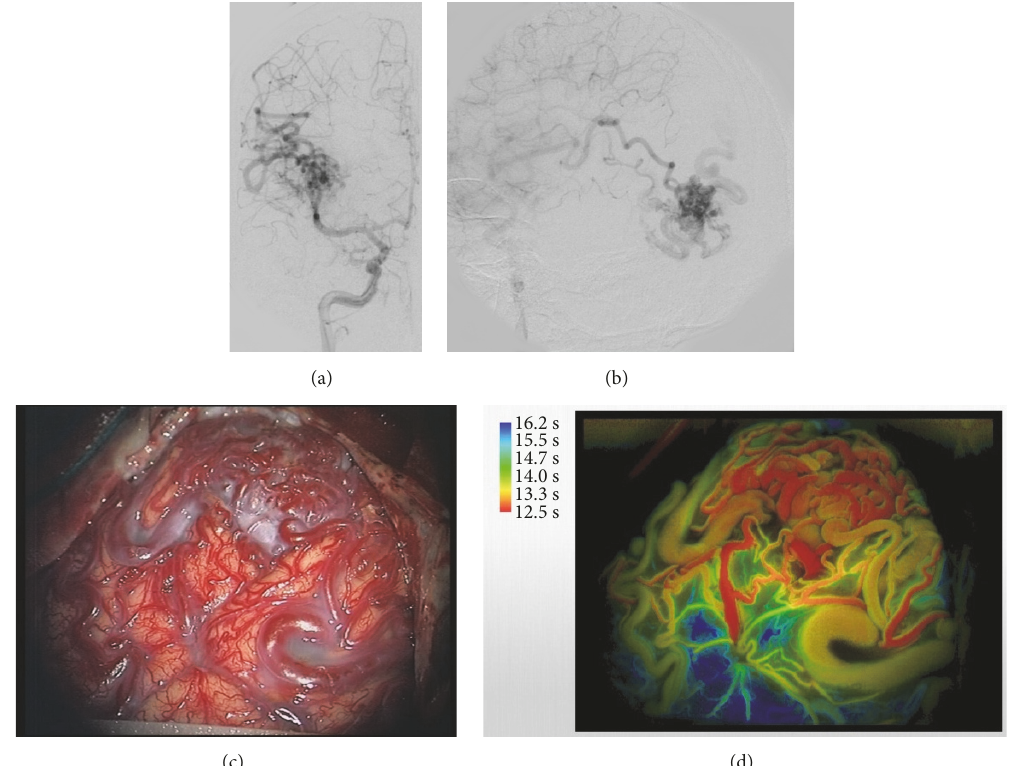
Figure 4: Case 5. Preoperative DSA showed an AVM in the right occipital lobe (a, b). Intraoperative photograph at after dural opening demonstrating surface appearance of the AVM (c). Delay map showing the feeders and accurate location of the nidus